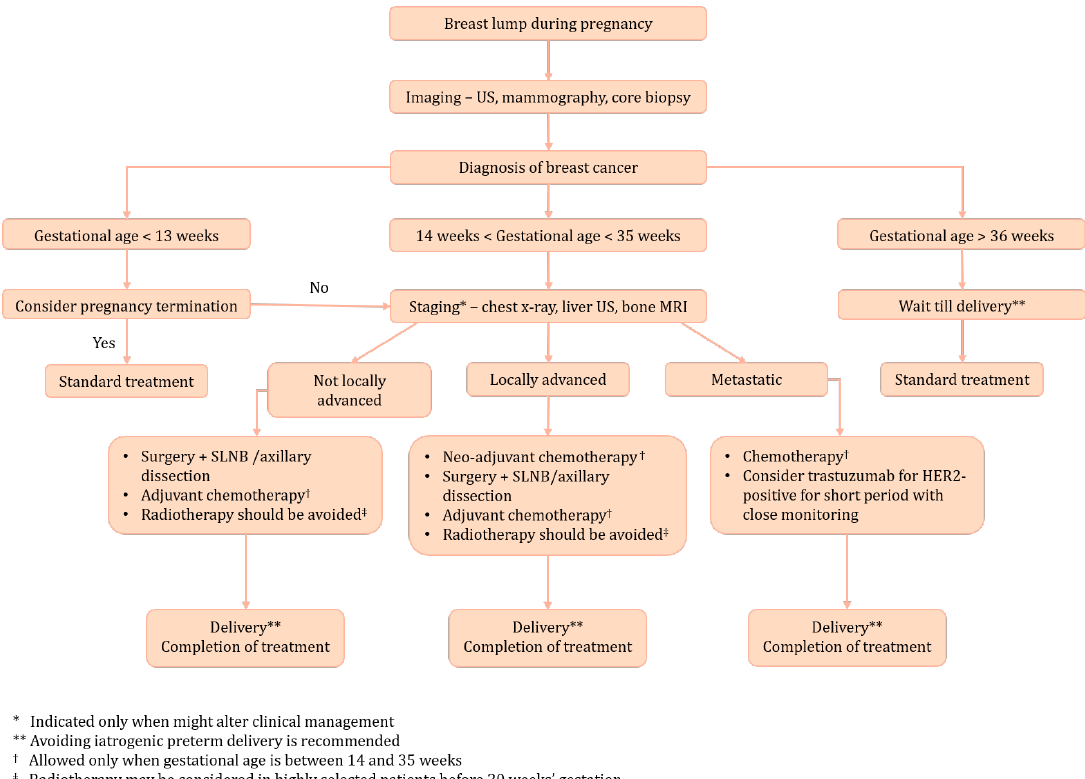
Figure 1. Management of pregnancy-associated breast cancer (PABC)